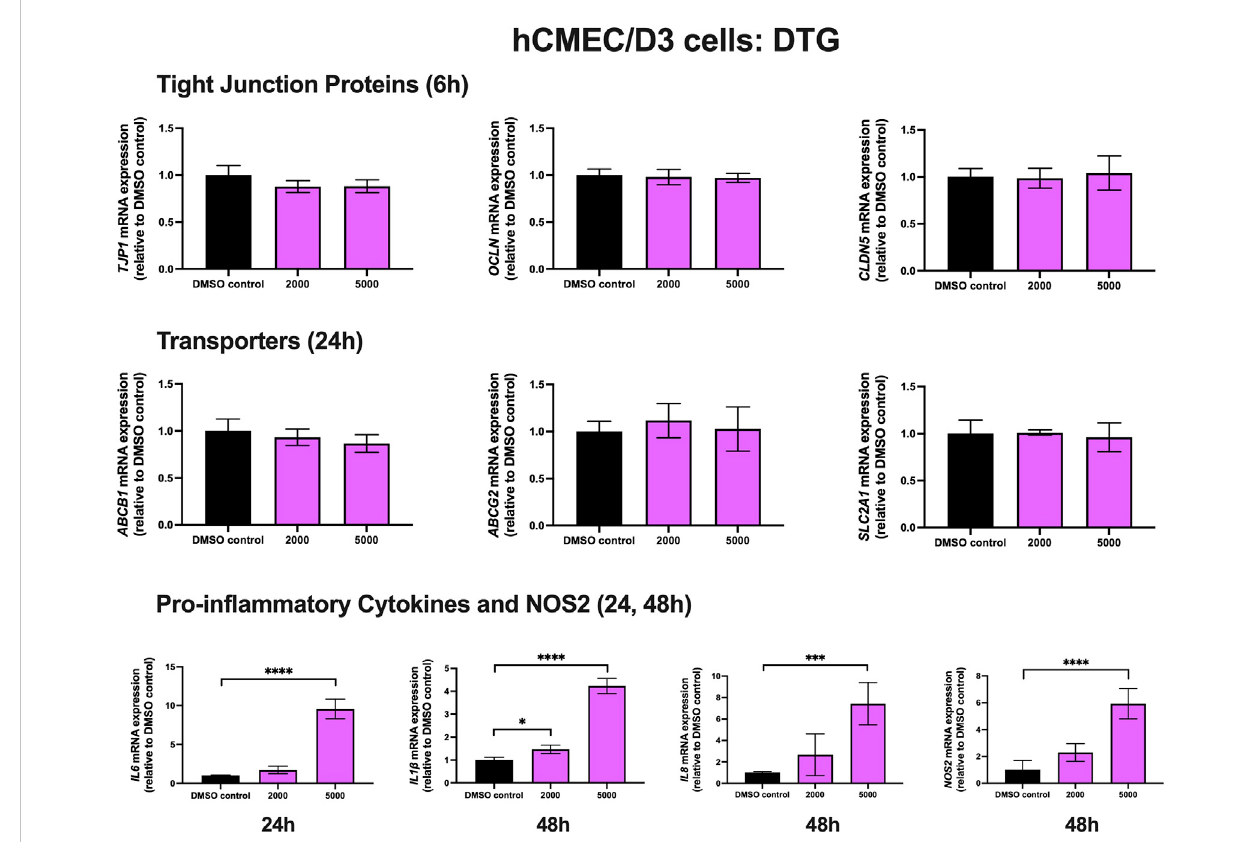
FIGURE 3 mRNA expression of TJ proteins, transporters, proin fl ammatory cytokines and NOS2 in hCMEC/D3 cells exposed to DTG (2,000, 5,000 ng/mL) or vehicle (DMSO) control for 6/24/48 h mRNA expression of TJP1, OCLN, CLDN5, ABCB1, ABCG2, SLC2A1, IL6, IL1 β , IL8 and NOS2 in hCMEC/D3 cells exposed to DTG relative to vehicle (DMSO) control was assessed by qPCR. Results are presented as mean relative mRNA expression ±SEM normalized to the housekeeping human cyclophilin B gene from n = 4 independent experiments. One-way ANOVA with Bonferroni ’ s post-hoc test, *, p < 0.05; ***, p < 0.001; ****, p <